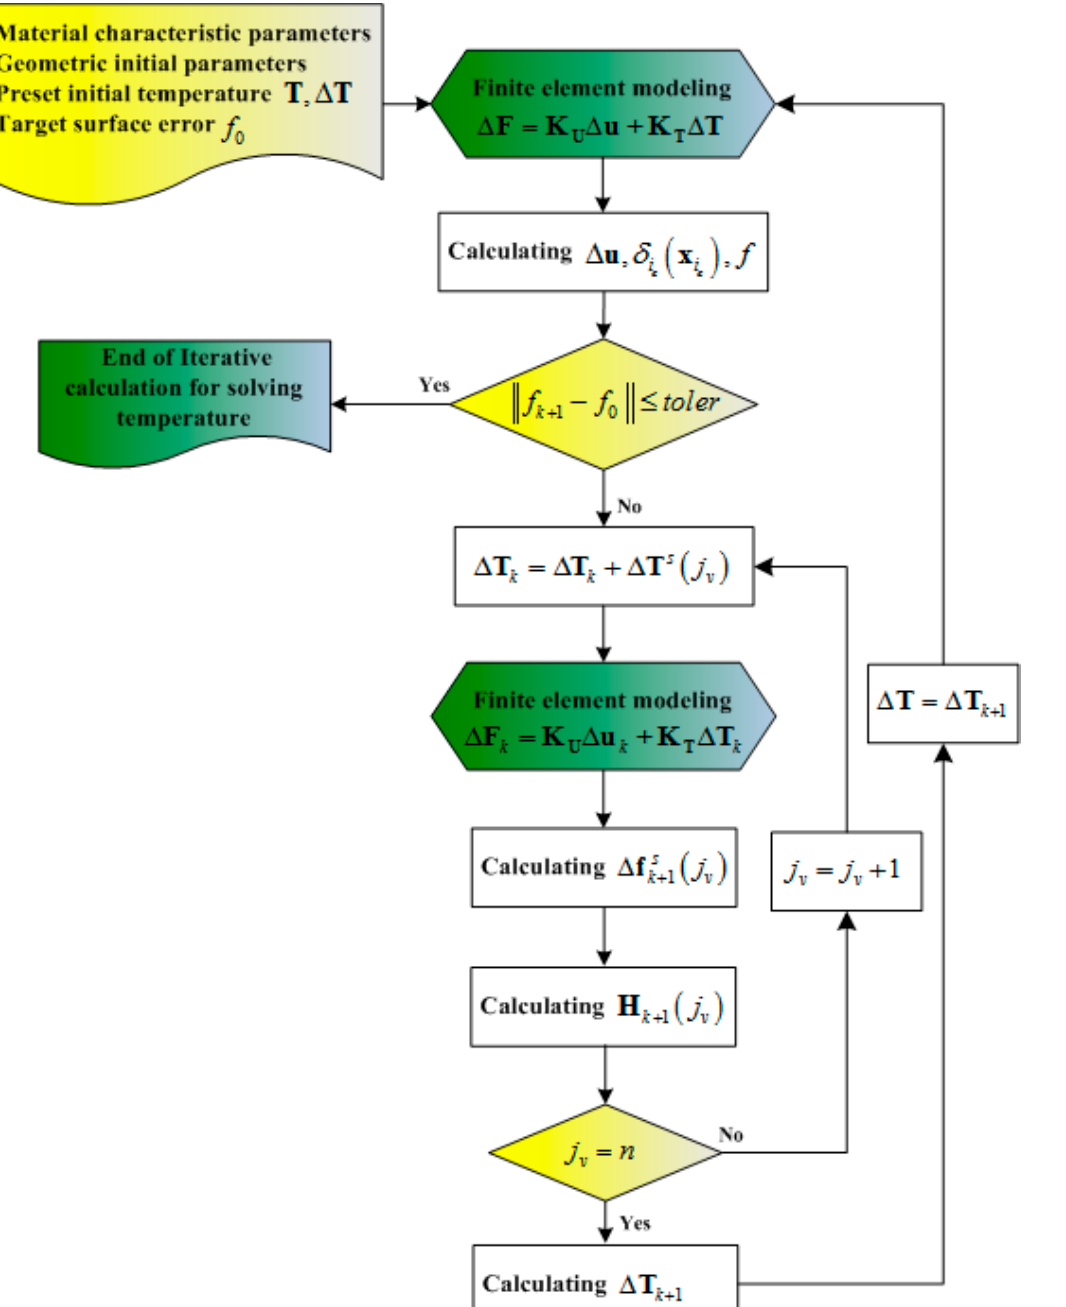
Figure 3. Flow chart of the iterative procedure to determine the applied temperature on shape memory alloy (SMA) to obtain the target surface error.